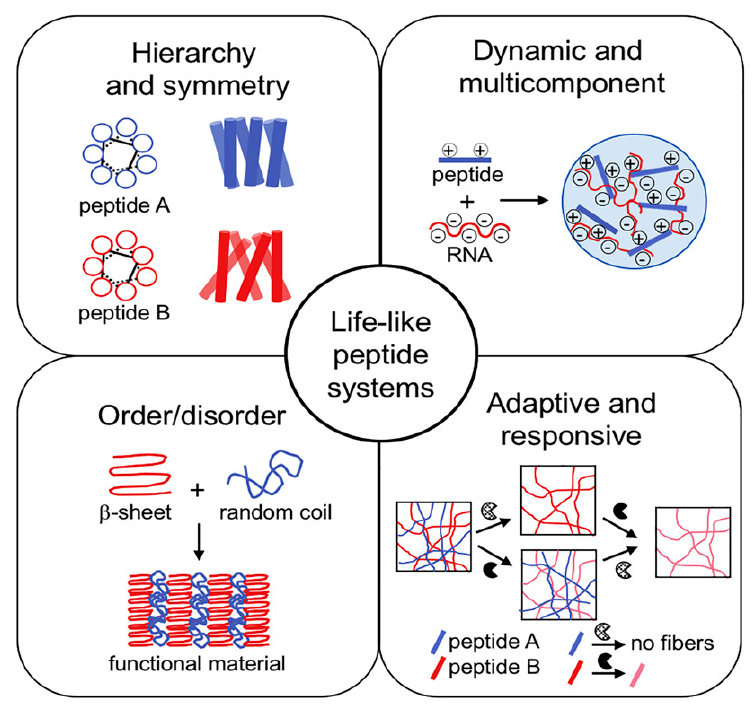
Figure 5. Life-like systems are out-of-equilibrium and present several useful features to mimic living tissues. Reproduced from [131], copyright © 2022, with permission from Elsevier.